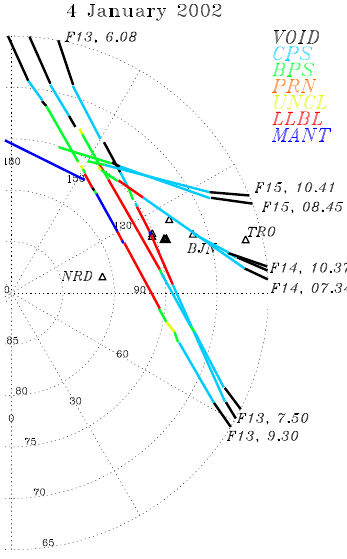
Figure 5. The superposition of the DMSP-identified boundary do- main ionospheric projections in the dayside hemisphere and sta- tion locations during the period of cusp observations by radar, from 07:00 to 11:00UT (in geomagnetic coordinates). The station with maximal ULF power is marked by a solid